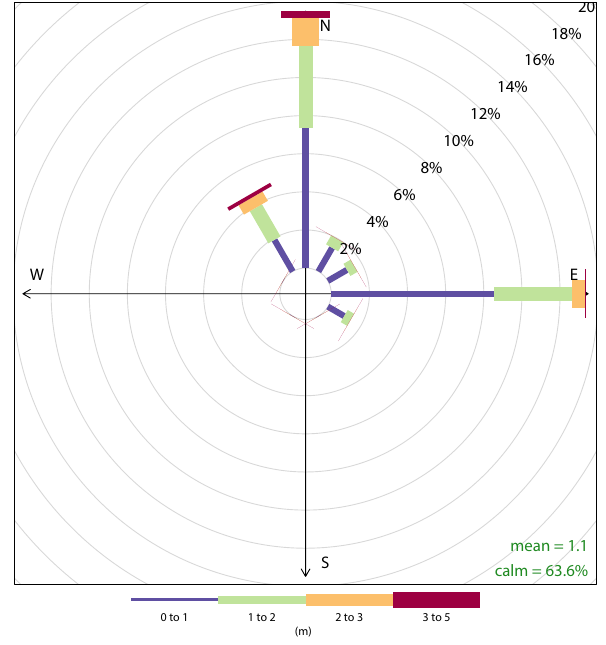
Figure 6. Observed wave climate over 12years of hourly time se- ries at Ortona (1989–2002).